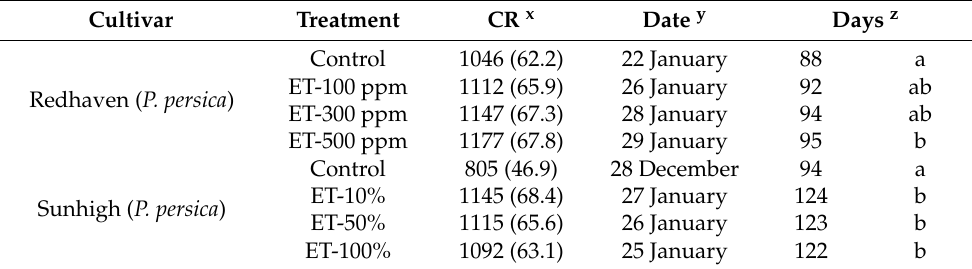
Table 1. Chilling requirements of peach cultivars as affected by autumn-applied ethephon.